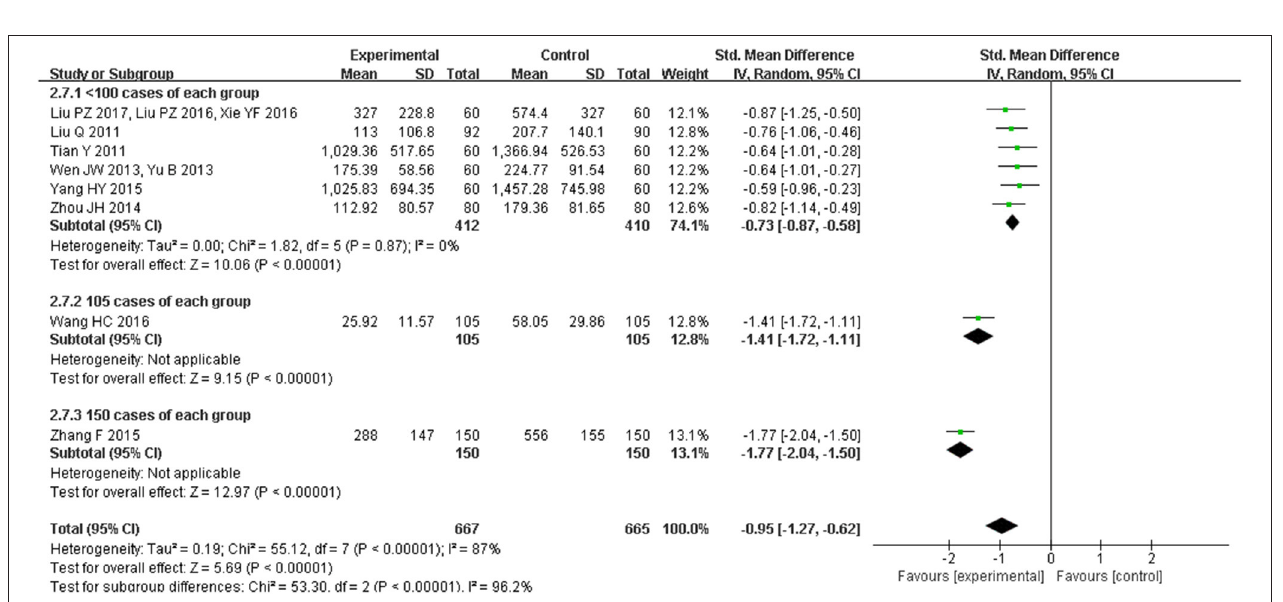
FIGURE 8 | Forest plot of the comparison between CHM and control for heart failure hospitalization in 6 months after discharge.